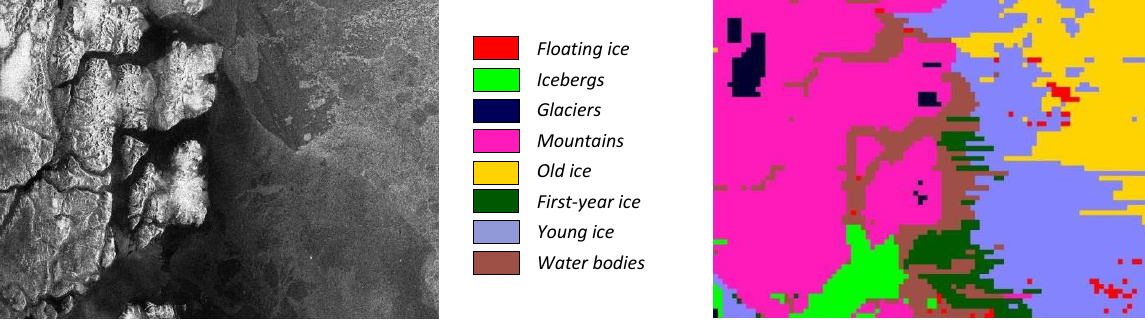
Figure 5.b. Sentinel-1 quick-look view (left) and a classification map (right) for an image of Belgica Bank, Greenland acquired on June 16 th ,